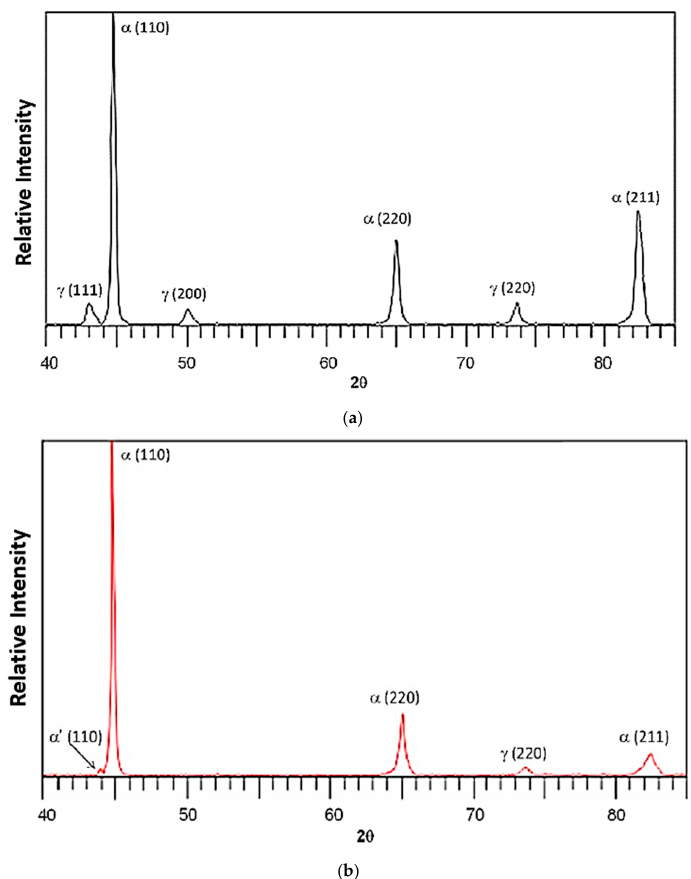
Figure 13. Difractograms for sample M390-300: ( a ) Without deformation y ( b ) After tensile test. Due to the fact that the M390-300 sample showed the best combination of retained austenite and C enrichment, a thermal study of the stability of the retained austenite was carried out in order to understand its influence on the mechanical properties. It is known that steels with TRIP behavior are very sensitive to the temperature at which they are mechanically tested because the retained austenite ( γ ) presents a behavior where the transformation to martensite ( α ’) is strongly dependent on temperature ( 𝑀 (cid:3046)(cid:3097) , 𝑀 (cid:3031) ) [32]. The results of the study of the influence of temperature on mechanical prop- erties for steel M390-300 and TRIP 780 are shown in Figure 14.